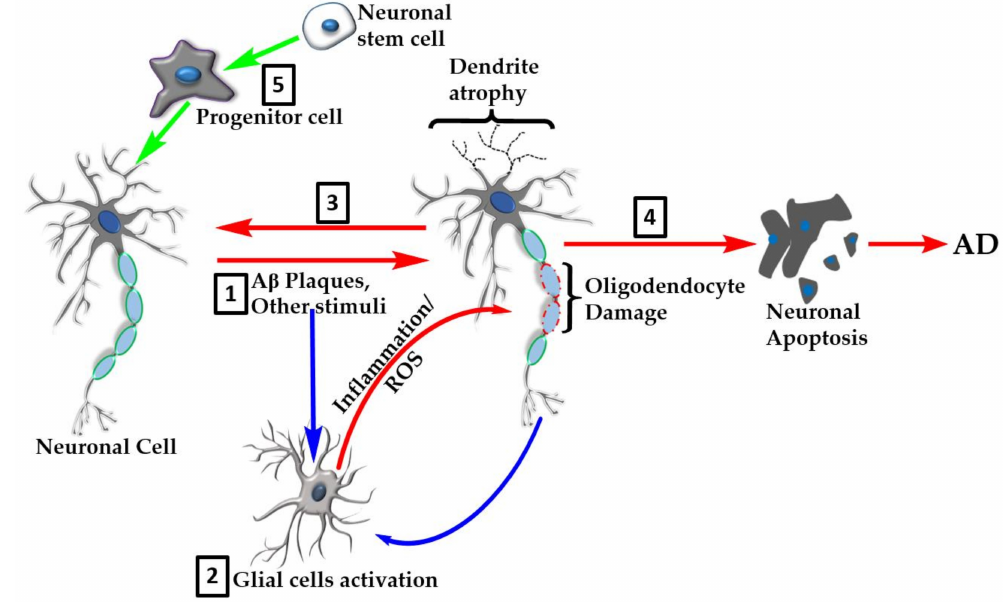
Figure 5. Overview of the natural products’ targets in AD. Many natural products show neuroprotective e ff ects in the various experimental models of AD through multiple mechanisms of action. These include direct e ff ect on neurotoxic agents such as A β plaque formation or tau hyperphosphorylation events ( 1 ). The neuroinflammation and oxidative stress linked to AD pathology is orchestrated through overactivation of glial cells ( 2 ) that serve as the major target for natural products. Glial cell targets include amelioration of proinflammatory cytokine production / action, removal of reactive oxygen species (ROS), and boosting of antioxidant defenses. Further e ff ects of natural products include promotion of recovery of damaged cells ( 3 ) or inhibition of neuronal apoptosis ( 4 ). Recent evidence also shows that natural products enhance neuroregeneration by promoting stem cells proliferation and di ff erentiation ( 5